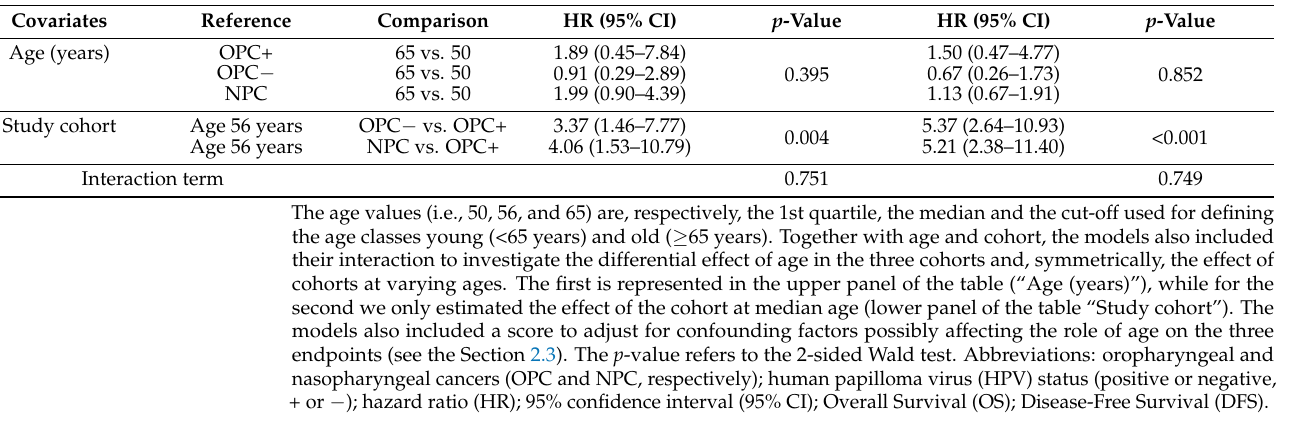
Table 3. Multivariable analyses of overall survival (OS) and disease-free survival (DFS).